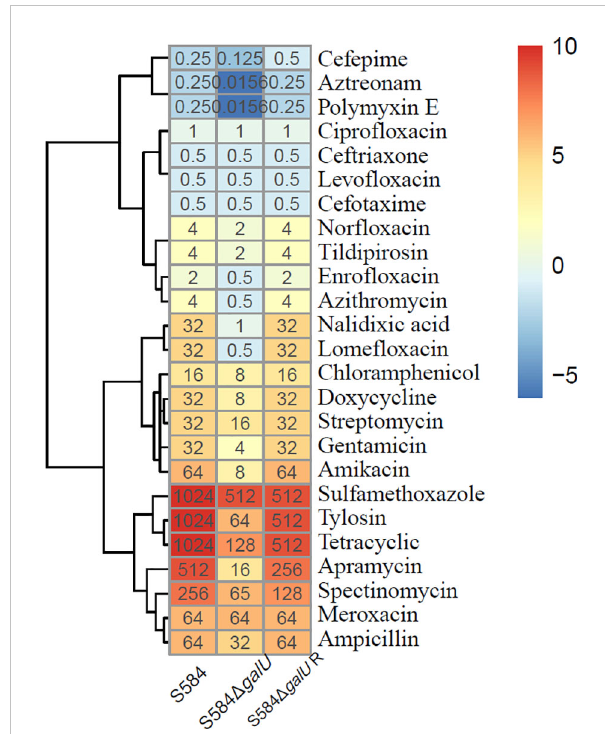
FIGURE 7 Comparison of antibiotic susceptibility of the three strains. Different colors represent the minimum inhibitory concentration (MIC) values of each strain to antibiotics; the darker the color, the higher the MIC for the antibiotic, indicating a strong resistance to the